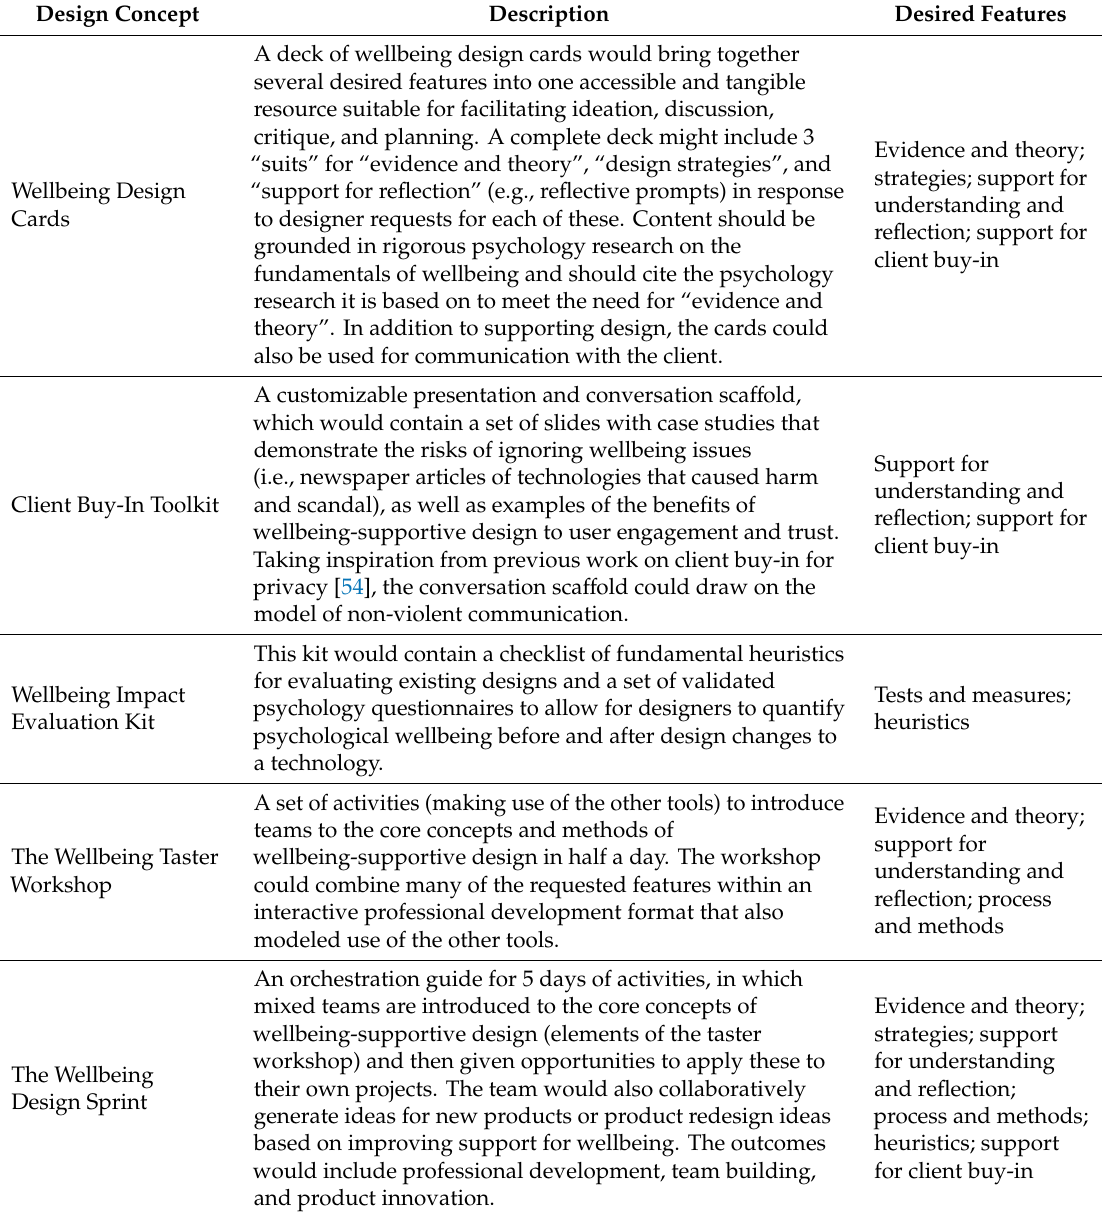
Table 1. Design concepts for practice tools addressing the features desired by designers in study